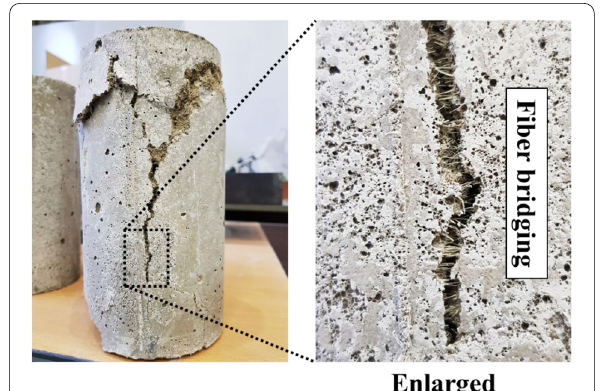
Fig. 16 Failed specimen under compression